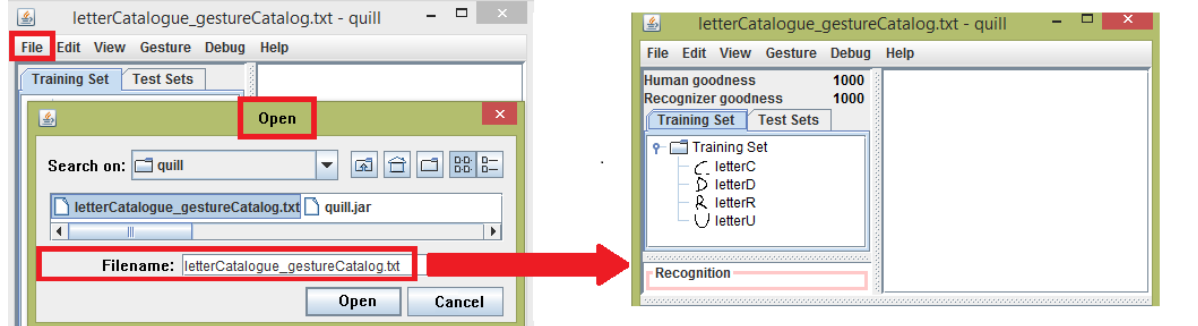
Figure 15. Importing the gesture catalogue to the quill